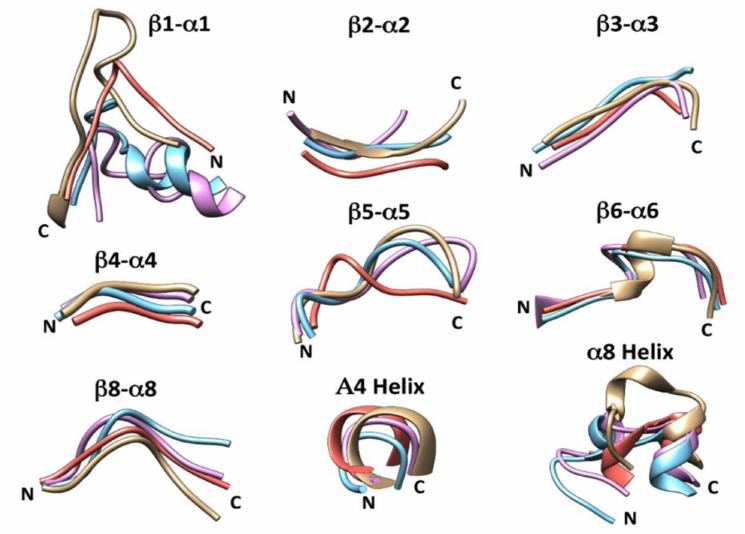
Figure 6. Comparison of conformations and lengths of the loops and α -helixes involved in the catalytic clefts. Models: Glt1 in cyan, Glt3 in purple and Glt20 in brown. The crystallographic